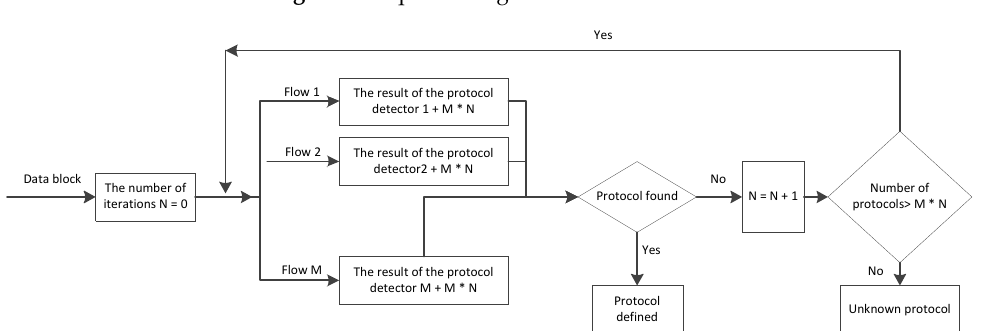
Figure 10. Parallel detection algorithm.